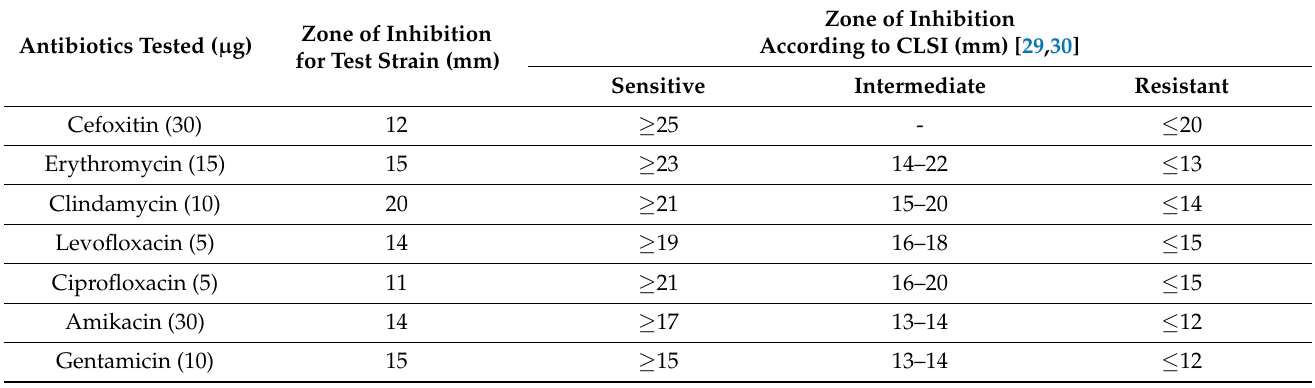
Table 1. Antibiotic susceptibility of S. aureus .